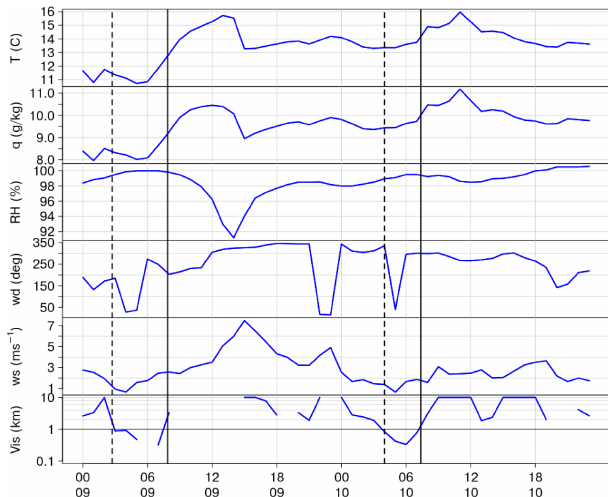
Figure 3. Meteorological variables from the Cimel Electronique compact weather station at the site during the two fog events on 9 and 10 September 2017. The variables are temperature ( T in degrees Celsius), water vapour mixing ratio ( q ), relative humidity (RH), wind direction (wd), wind speed (ws), and visibility (Vis) from the transmissometer. Vertical black dashed (solid) lines indi- cate fog start (end) times. The x axis shows hours in UTC (site is UTC + 2) and the day of the month in